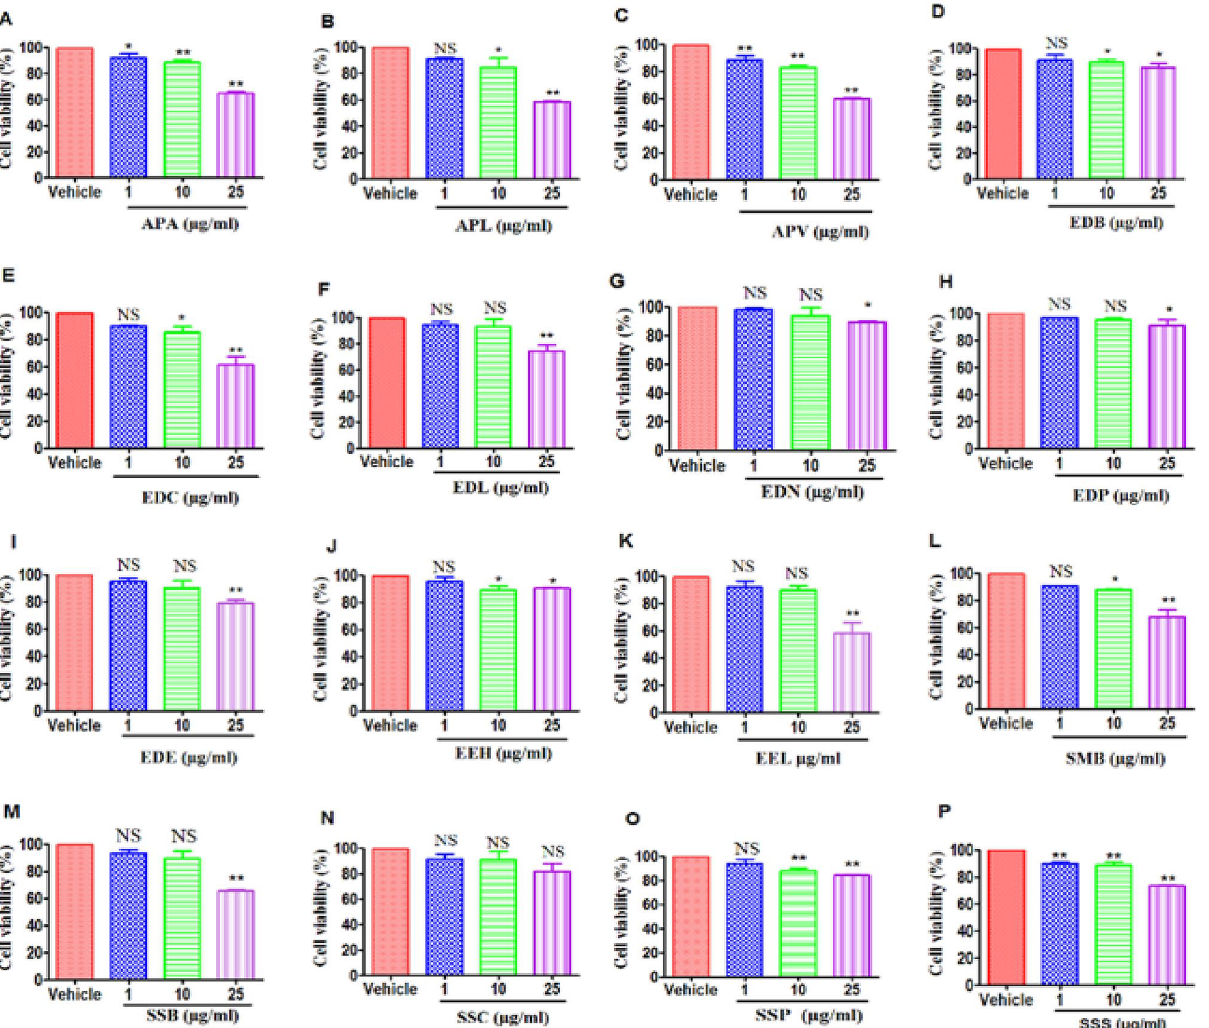
Figure 3. Effect of treatment of B16 melanoma cells with plant extracts on cell viability: EL-4 cells were cultured with various plant extracts or DMSO as vehicle, for 24 h. The cell viability was next measured by using the MTT test. ( A – C ) represent the Asteraceae family (( A ) APA, ( B ) APL, ( C ) APV). ( D – I ) represent the Ebenaceae family (( D ) EDB, ( E ) EDC, ( F ) EDL, ( G ) EDN, ( H ) EDP, ( I ) EDE). ( J – K ) represent the Erythroxylaceae family (( J ) EEH, ( K ) EEL). ( L – P ) represent the Sapotaceae family (( L ) SMB, ( M ) SSB, ( N ) SSC, ( O ) SSP, ( P ) SSS). The vertical bars represent mean ± S.E.M. of three independent experiments. The significance between various groups was tested using one-way ANOVA where NS: not significant; (*)p < 0.05, (**)p < 0.01, (***)p < APL plant extracts induce apoptosis in EL4 and B16 tumor cells. To understand if APL extracts were inducing apoptosis, we performed staining of cells with AnnexinV and PI. To this end, both cancer cell lines were treated with various doses of APL (1, 10, 25 µg/ml dry crude leaf extract) or DMSO for 24 h followed by staining of cells with Annexin V/PI followed by flow cytometric analysis. In this assay, cells stained for Annexin V only were indicative of early apoptotic cells and those stained for both Annexin V and PI are considered to be late apoptotic cells, while cells stained only for PI were considered to be necrotic cells. The data obtained from Annexin V/PI is graphically presented in a dot plot diagram in Figs. 4 and 5 which demonstrated that both EL4 and B16 cells underwent significant levels of early and or late apoptosis and necrosis in a dose-dependent man- ner. Treatment of EL4 cells with APL induced a dose-dependent increase in early apoptotic cells. At the highest dose tested (25 µg/ml of dry crude leaf extract), there was also an increase in late apoptosis (62.6%) and slowly shifting to necrotic cells (14.2%) (Fig. 4D). On the other hand, treatment of B16 melanoma cells at 25 μg/ml dose of APL caused a dramatic increase in late apoptotic cells (75.3%) shifting to necrotic cells (8.03%) (Fig. 5D). Because there was some background apoptosis in vehicle controls, the data were also expressed to indicate the level of apoptosis in extracts after subtracting the apoptosis seen in vehicle controls (Figs. 4E, 5E).